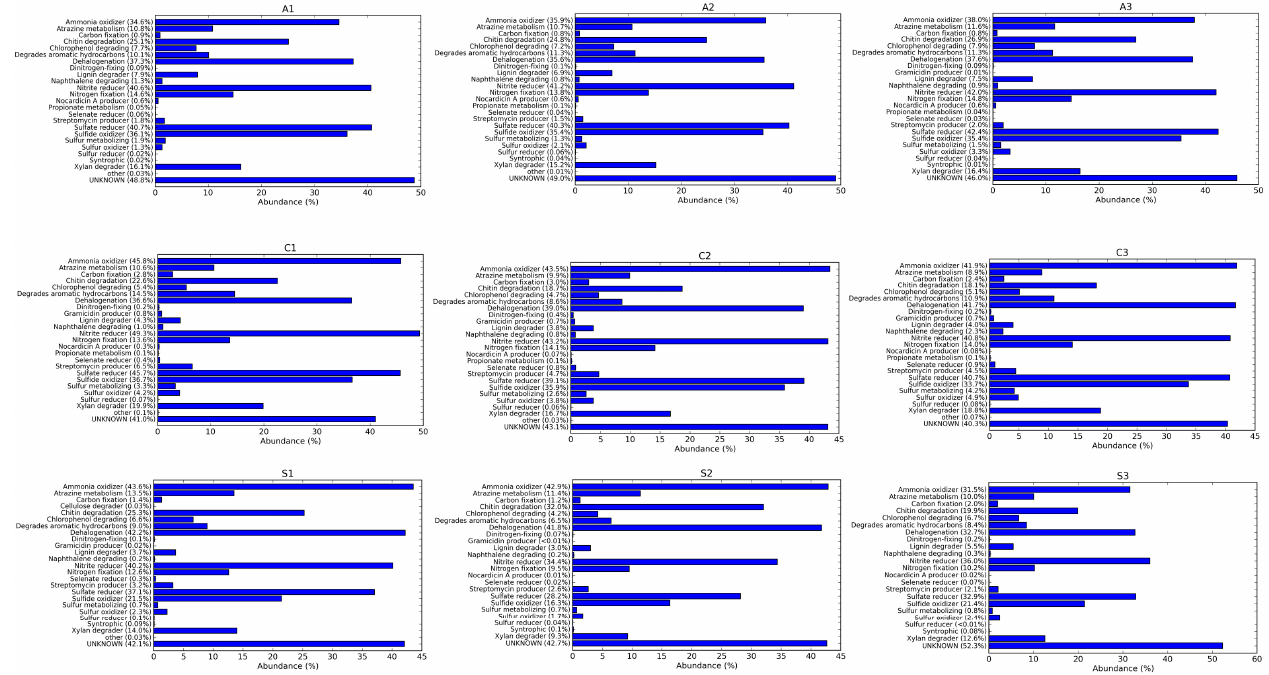
Figure 6. KEGG analysis of rice rhizosphere soil of three different rice planting systems.